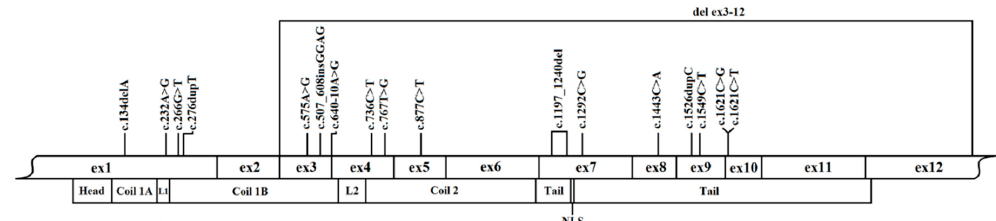
Figure 1. Distribution of LMNA variants in our study cohort. Legend: NLS, nuclear localization signal.